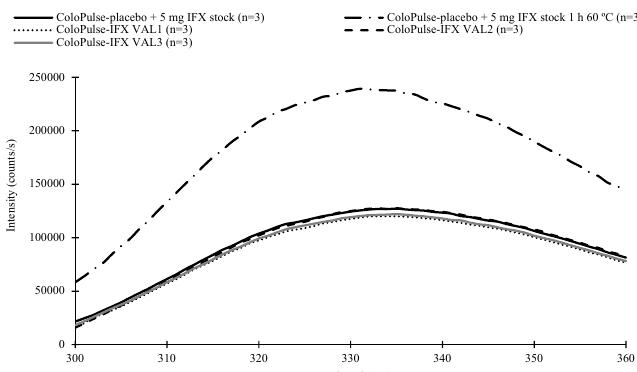
Figure 3. The average ( n = 3) intrinsic fluorescence spectra of the three validation batches (VAL1-3) of ColoPulse-IFX, ColoPulse-placebo spiked with 5 mg fresh IFX stock, and ColoPulse-placebo spiked with 5 mg fresh IFX stock stressed for 1 h at 60 °C. Excitation wavelength was λ = 295 nm.